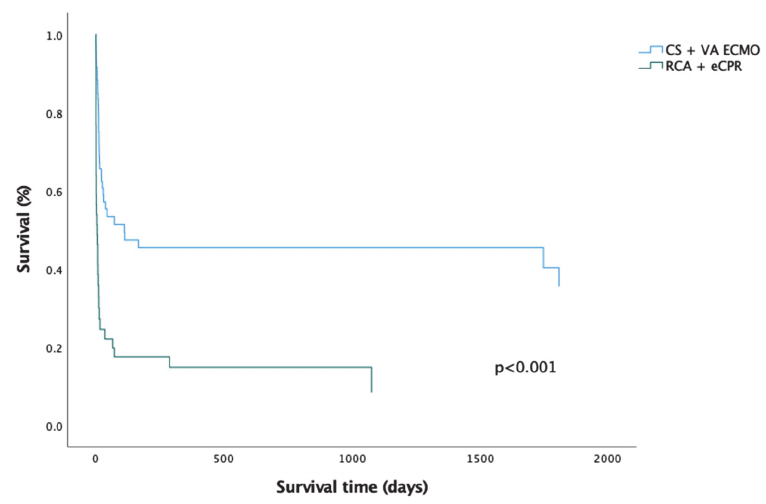
count, C reactive protein, and procalcitonin) and increased requirement of vasopressors.